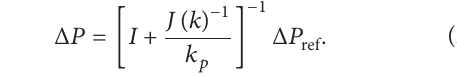
to illustrate the droop control and the influence of active power reference change on the distribution of power between